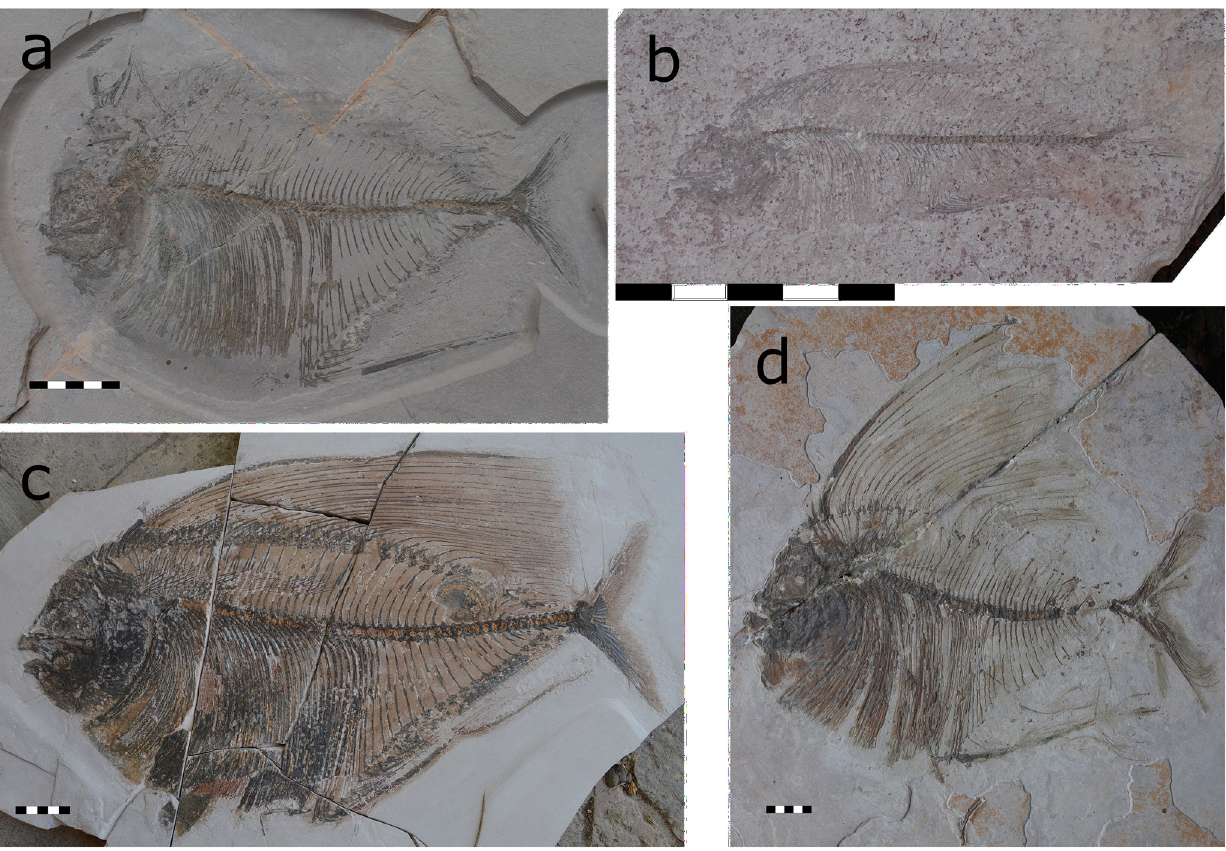
Fig 2. Preservational stages of the dorsal fin of T . formosa . Disarticulated dorsal fin (CPC-2892) (A). Folded dorsal fin classified as ‘not spread’ (ns) within a range of 0˚—20˚ (CPC-2841) (B). Middle spread dorsal fin (ms) within 21˚ to 40˚ (CPC-2948; REG2544 PF48) (C) and full spread (fs) dorsal fin ( > 41˚) (CPC-2839) (d). All scales 50